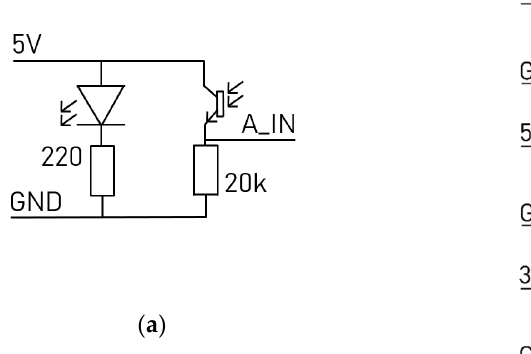
Figure 10. ( a ) Breathing belt circuit; ( b ) ear clip heartbeat sensor circuit; ( c ) pressure, finger heartbeat sensor circuit; ( d ) ECG circuit.